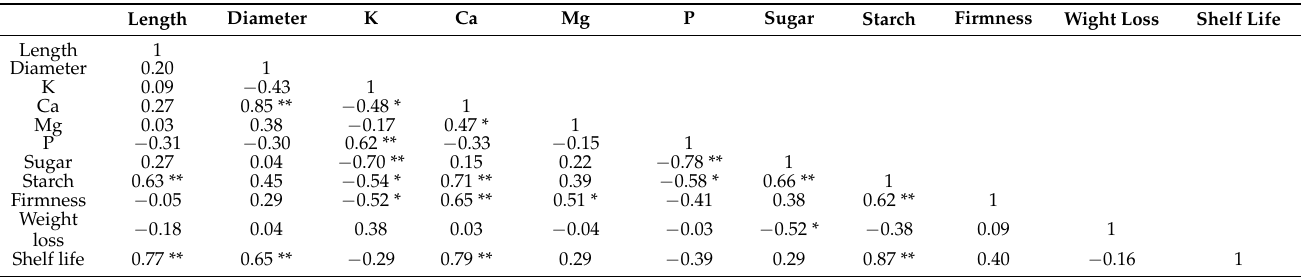
Table 6. Pearson’s correlation coefficients between fig indices under different color nets.